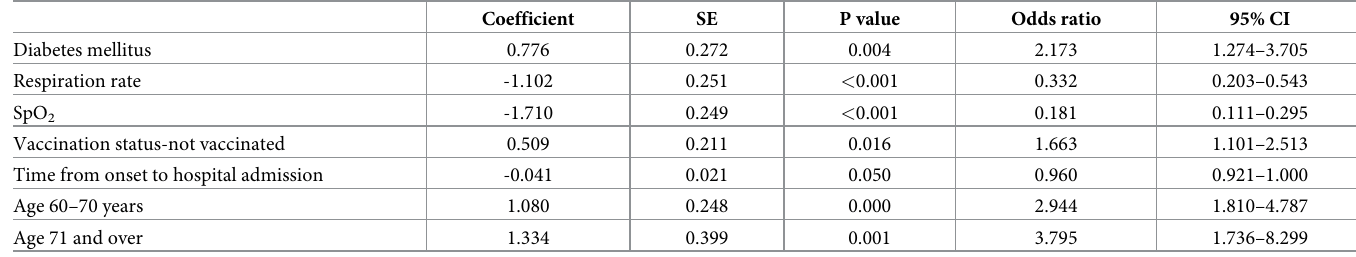
Table 5. Risk factors of mortality among patients with COVID-19 using a logistic regression